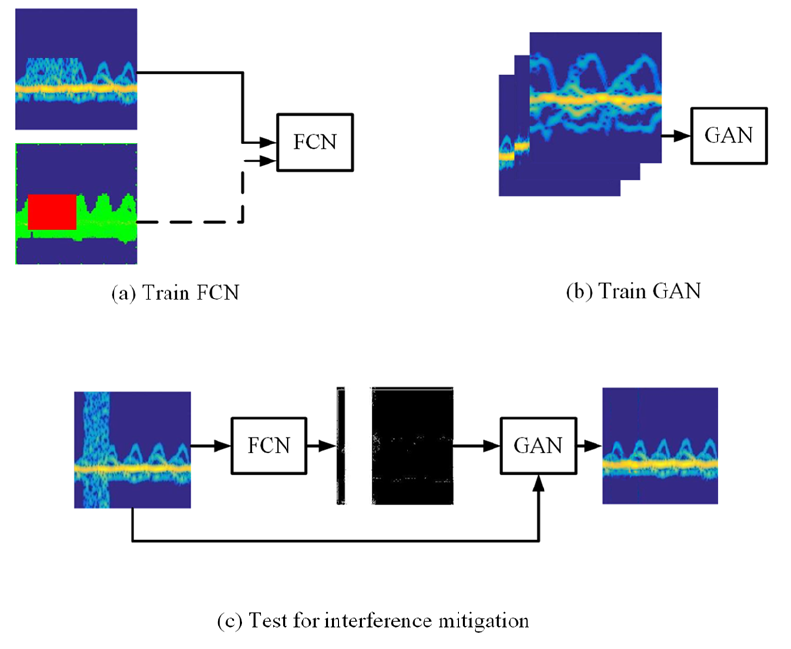
Figure 1. The pipeline of the proposed deep-learning method for interference restoration. ( a ) The FCN is trained with the spectrograms where there is interference with the supervision of the label. Then when a spectrogram with interference is fed into the trained FCN, the FCN can locate the interference accurately. ( b ) The GAN is trained with clear radar spectrograms. In this way, the GAN can learn the data distribution of clear spectrograms for further interference mitigation. ( c ) Finally, when a spectrogram with interference is fed into the FCN and fed into the GAN subsequently, a clear spectrogram can be